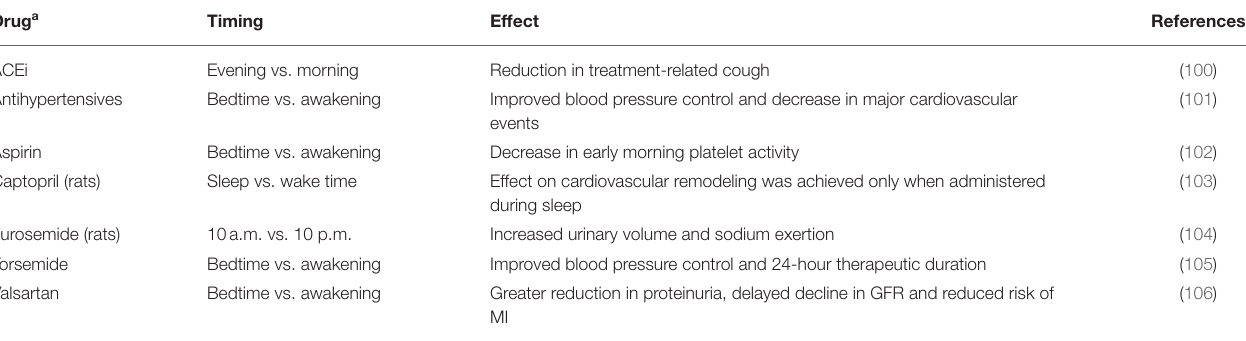
TABLE 1 | Examples of the linkage between administration time and effect in cardiovascular drugs. Drug